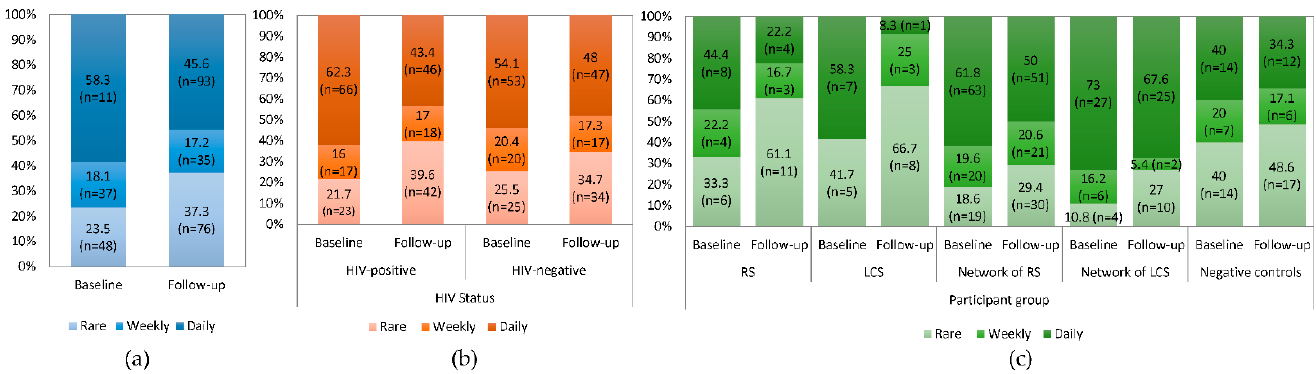
Table 2. Odds ratios (OR) and 95% confidence intervals (CI) of univariable and multivariable binary logistic regression models for participants responses to questionnaire items of drug injection-related behaviors (safe versus risky) at follow up [Q4: When you injected drugs, what proportion of the time did you share a syringe that someone else had previously used to inject? (Q4a), share a cooker, filter or rinse water that someone else had previously used to inject? (Q4c)].